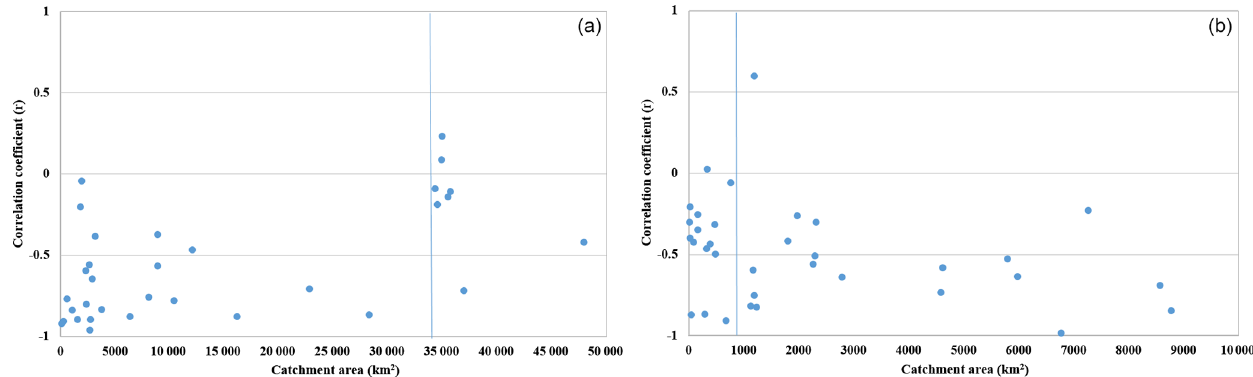
Figure 9. Catchment area and correlation coefficient of each site in the Mississippi River